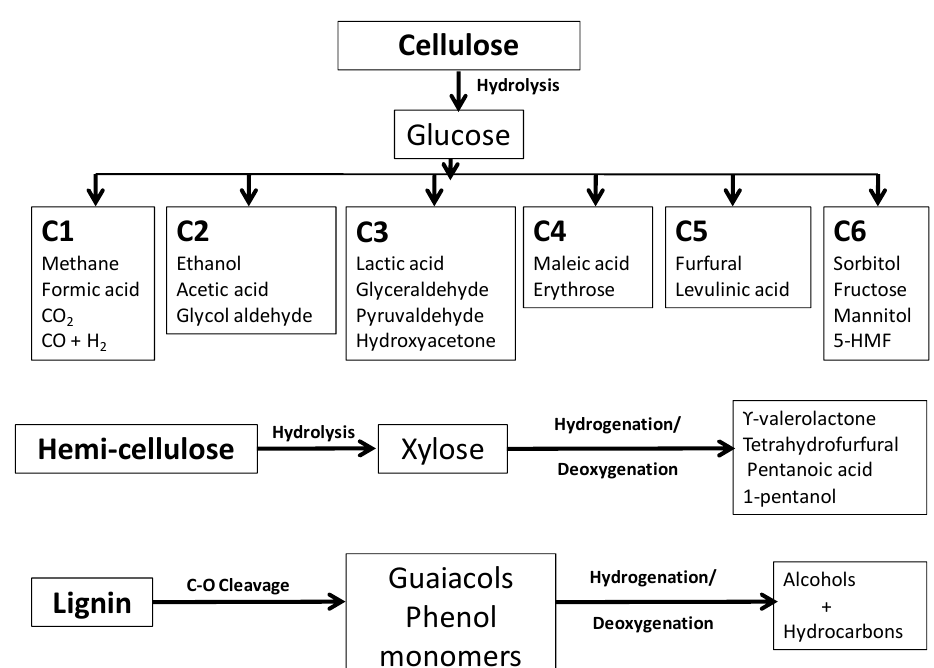
Figure 2. Potential chemicals and fuels obtained from lignocellulosic biomass.